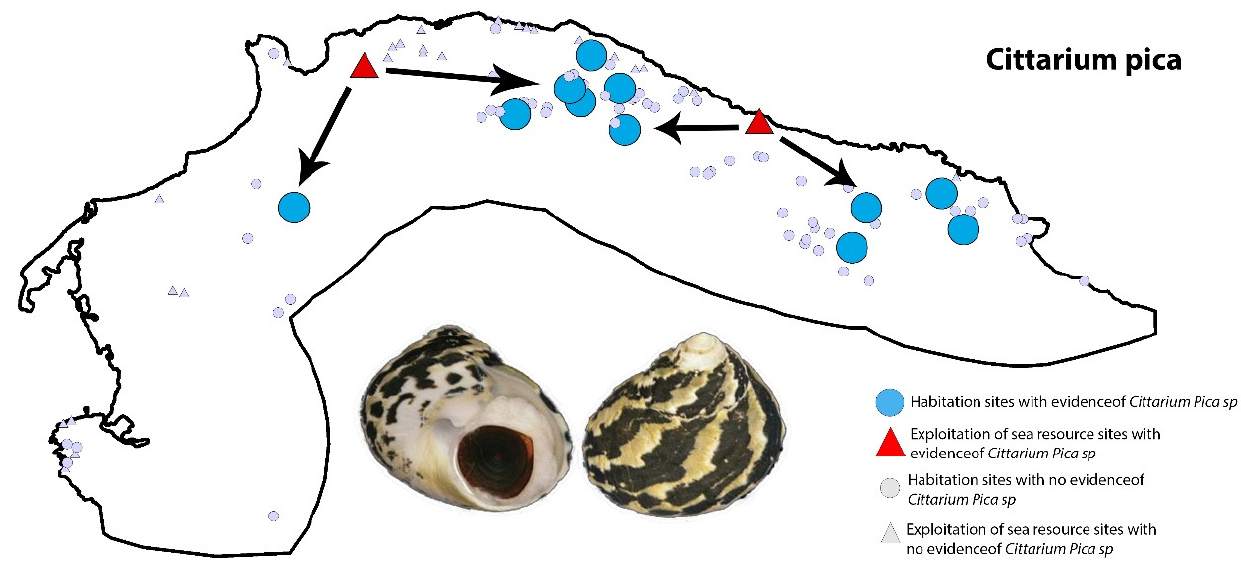
Figure 4. Ideal representation of medium-scale taskscapes.